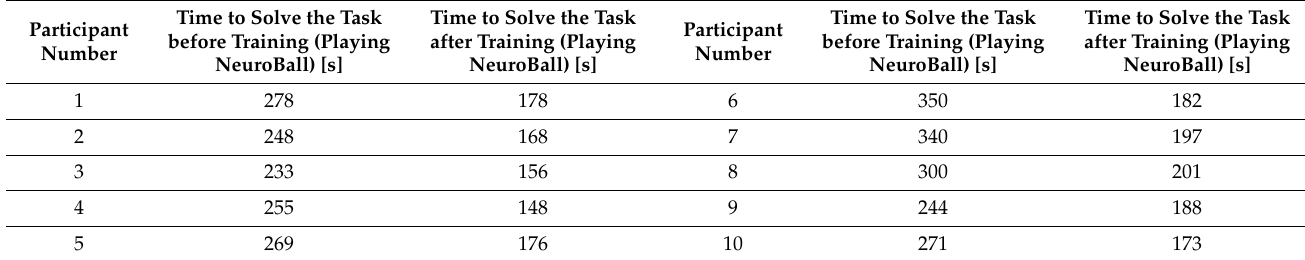
Table 2. Time to solve math problems before and after training with